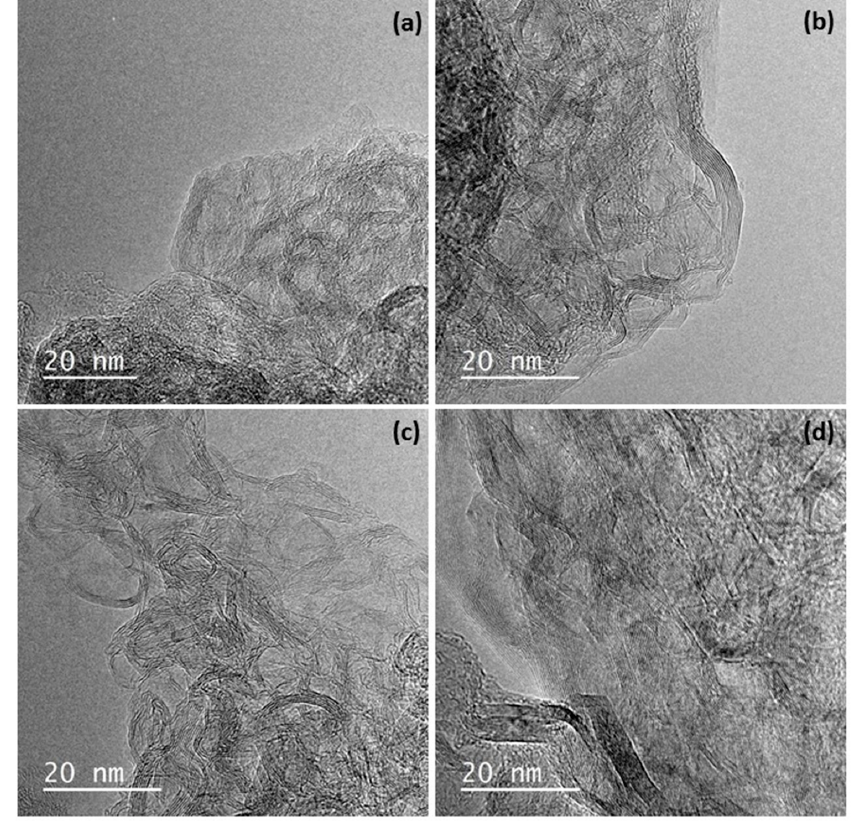
Figure 2. HRTEM images of samples: ( a ) GX-100, ( b ) GX-300, ( c ) GX-100 GO, and ( d ) GX-300 GO. Table 1. Structural properties of the samples Graphitic